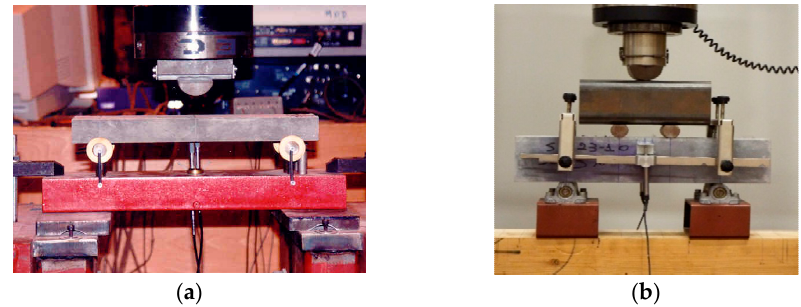
Figure 3. Experimental setup for the testing of (a) UHPFRC-1 and (b) UHPFRC-2 beams.